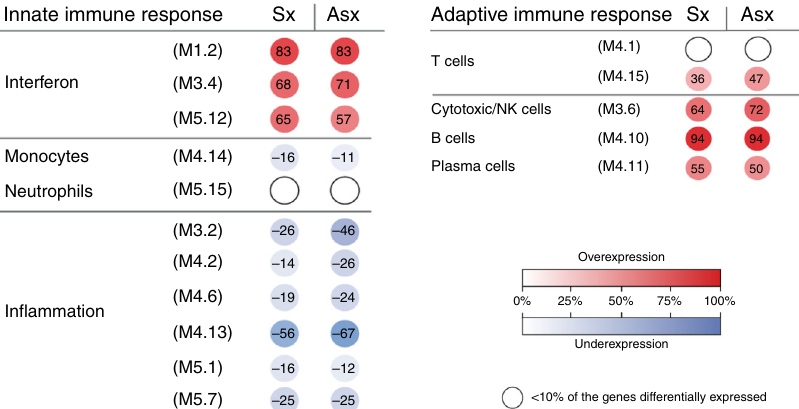
Fig. 3 Modular expression in symptomatic and asymptomatic cCMV infection. Modules (M) are groups of genes that are co-expressed and shared a similar biological function. Sixteen selected modules pertaining to innate and adaptive immune responses are represented above and included three related to interferon, one to monocytes, one to neutrophils, six to in fl ammation, two T cell related, one related to cytotoxic/NK cells, one plasma cell, and one B-cell related. The intensity of the modules (dots) indicate the proportion of overexpressed (in red) or underexpressed (in blue) transcripts within each module. Numeric values indicate the percentage of transcripts expressed in each speci fi c module compared with healthy controls. Blank dots indicate that <10% of the genes in the module were differentially expressed compared with controls. The panel on the left includes innate immunity-related modules, and the panel in the right is comprised of adaptive immunity modules. Sx symptomatic, Asx